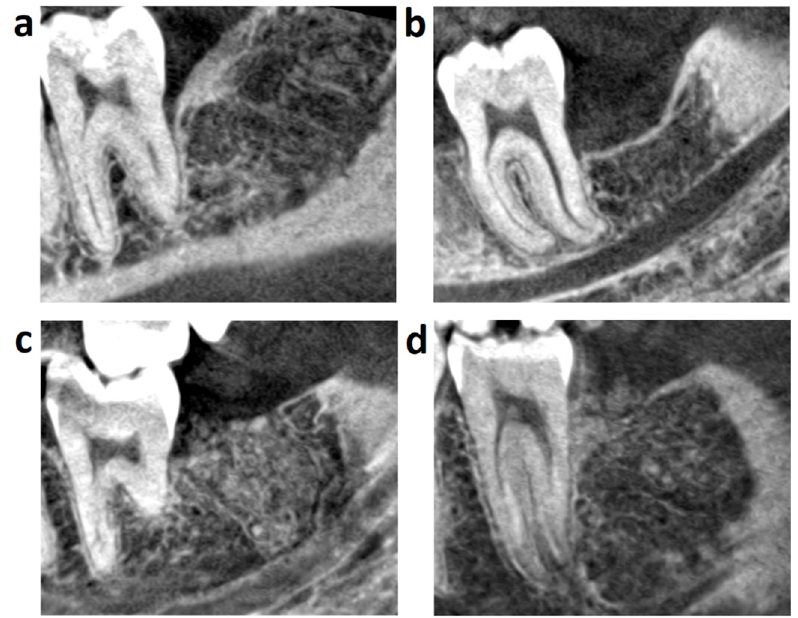
Figure 2. One year follow-up CBCT images: ( a ) Control healed without significant MBL loss, new bone is homogenous, layered by continuous cortical; ( b ) Control healed with more than 3 mm MBL loss, new bone is homogenous, layered by fenestrated cortical; ( c ) Grafted socket regenerated by the homogenous bone formation and lack of cortical layer; ( d ) Grafted socket regenerated by homogenous bone formation with visible graft remnants and layered by fenestrated cortical. Table 2. Bone morphometric characteristics were analysed by CTAn software according to the